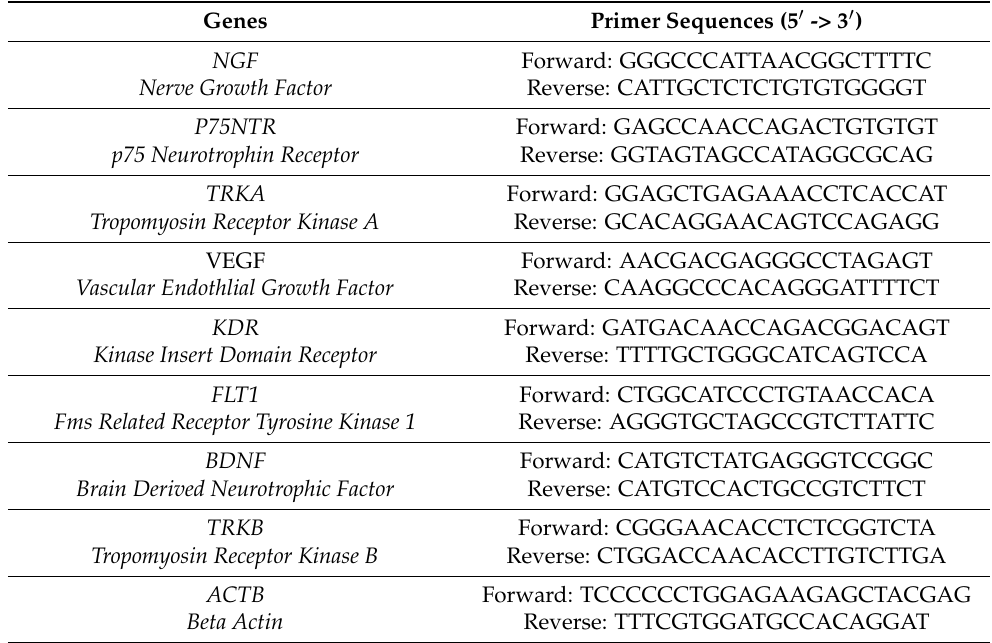
Table 1. List of the gene specific primer sequences. Genes Primer Sequences (5 (cid:48) -> 3 (cid:48) ) NGF Forward: GGGCCCATTAACGGCTTTTC Nerve Growth Factor Reverse: CATTGCTCTCTGTGTGGGGT P75NTR Forward: GAGCCAACCAGACTGTGTGT p75 Neurotrophin Receptor Reverse: GGTAGTAGCCATAGGCGCAG TRKA Forward: GGAGCTGAGAAACCTCACCAT Tropomyosin Receptor Kinase A Reverse: GCACAGGAACAGTCCAGAGG VEGF Forward: AACGACGAGGGCCTAGAGT Vascular Endothlial Growth Factor Reverse: CAAGGCCCACAGGGATTTTCT KDR Kinase Insert Domain Receptor Reverse: TTTTGCTGGGCATCAGTCCA FLT1 Forward: CTGGCATCCCTGTAACCACA Fms Related Receptor Tyrosine Kinase 1 Reverse: AGGGTGCTAGCCGTCTTATTC BDNF Forward: CATGTCTATGAGGGTCCGGC Brain Derived Neurotrophic Factor Reverse: CATGTCCACTGCCGTCTTCT TRKB Forward: CGGGAACACCTCTCGGTCTA Tropomyosin Receptor Kinase B Reverse: CTGGACCAACACCTTGTCTTGA